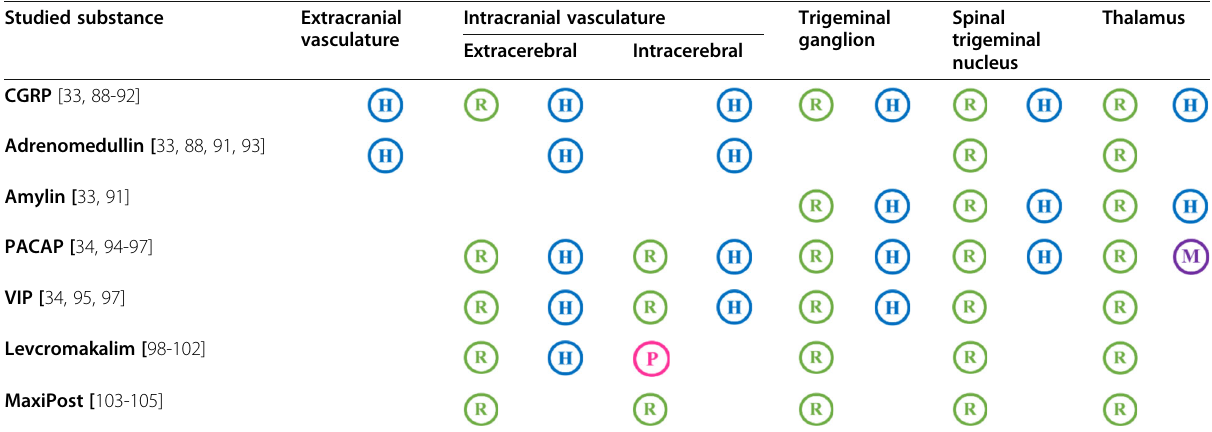
Table 2 Receptor binding sites within the trigeminovascular system. The table gives an overview of seven different migraine- inducing substances and their various binding sites within the trigeminovascular system. In this table, the trigeminovascular system is divided into the following structures: extracranial vasculature, intracranial vasculature, the trigeminal ganglion, the spinal trigeminal nucleus, and thalamus. The binding sites have been detected by usage of polymerase chain reaction, in-situ hybridization, western blot, or immunostaining in